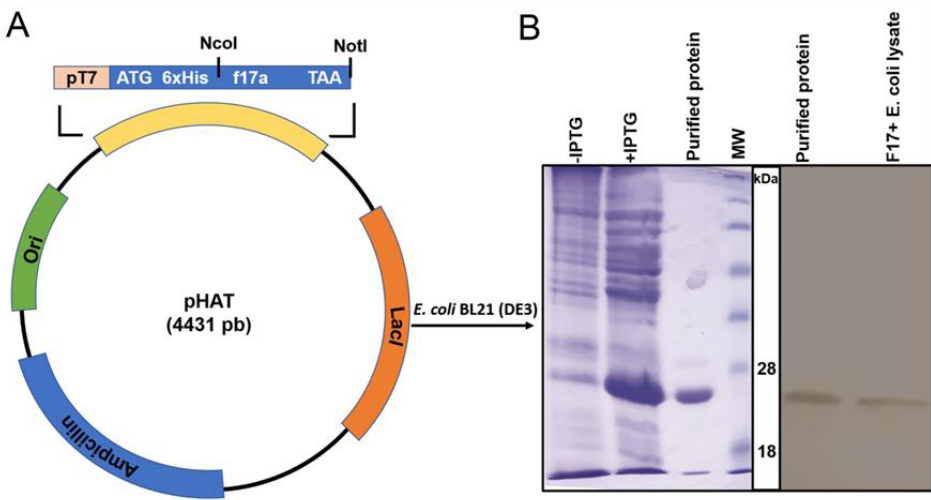
Figure 1. ( A ) Schematic representation of the plasmid construct used to express F17A protein. The f17a gene was cloned downstream 6xHis tag for periplasmic expression. ( B ) F17A recombinant protein expression after induction of BL21 (DE3) cells with IPTG was detected by SDS-PAGE. Cell lysates before induction with IPTG ( − IPTG) or after induction with IPTG (+IPTG) showing an intense band at about 20 kDa, the expected size of F17A and the FPLC purified and desalted F17A protein. MW: See Blue Protein standard (Thermo scientific, Waltham, MA, USA), 18 and 28 kDa bands are indicated. Detection of F17A protein by western blot with the developed polyclonal antibody from purified recombinant F17A protein and the native F17A protein from an F17 – positive E. coli diarrheic strain.